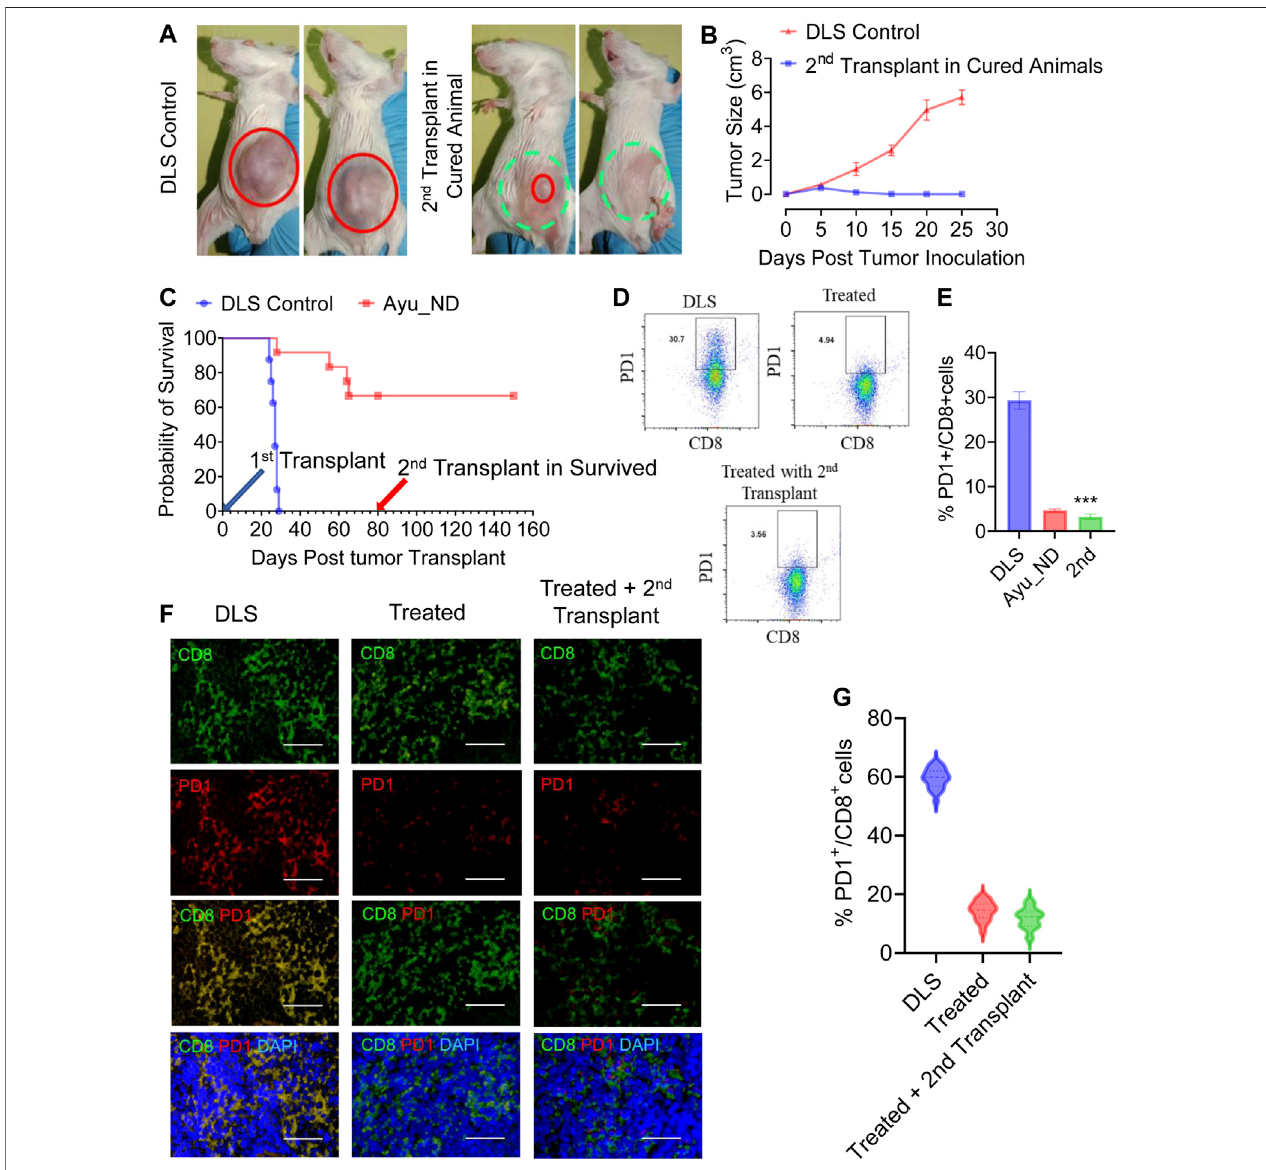
FIGURE 8 | Immunity induced by Ayu_ND treatment is long-lived. The growth of subcutaneous tumors in naïve control mice and mice survived and rechallenged > 2 monthsafter primary tumorrejection (A) .Completenonappearanceofatumor isdisplayed (B) ,andenhanced survivalwasobservedwithfurthertreatment (C) inthe case of rechalange experiments. The number of PD1-expressing CD3 + CD8 + T cells was higher in the untreated mice than in the other groups of tumor-draining lymphocytes (D , E) . Paraf fi n sections derived from untreated, treated withAyu_ND or rechalanged mice after curing with Ayu_ND treatment were stained with anti- mouse PD-1 (red) and counterstained with anti-mouse CD8 (green) and DAPI for nuclei (blue). Colocalization of these two markers was detected by merging the monostaining pictures ( n =5). Scalebar, 50 mm (F) . Quantitative estimation ofthe percentagesofPD-1 + and CD8 + Tcells ispresented in thebar graph( n =5) (G) . Data represent the mean ± SE of n = 3 – 5 animals per group. NS, no signi fi cance; * p < 0.05, ** p < 0.01, *** p < 0.001, and **** p < 0.0001.